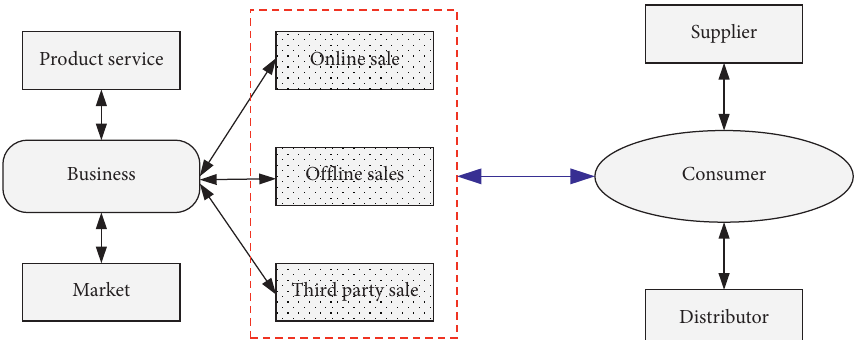
Figure 3: The relationship between the analysis function provided by the supply-demand relationship platform and the consumption behavior analysis model.